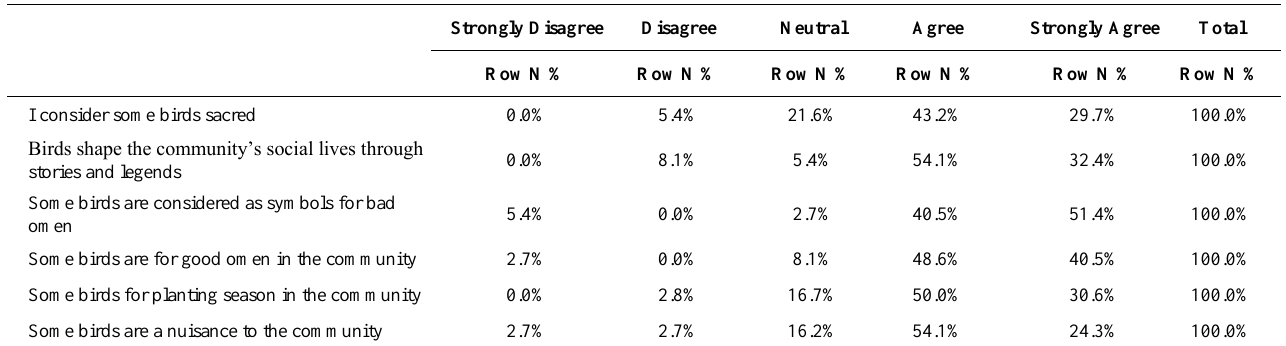
Table 2 . Birds and habitat